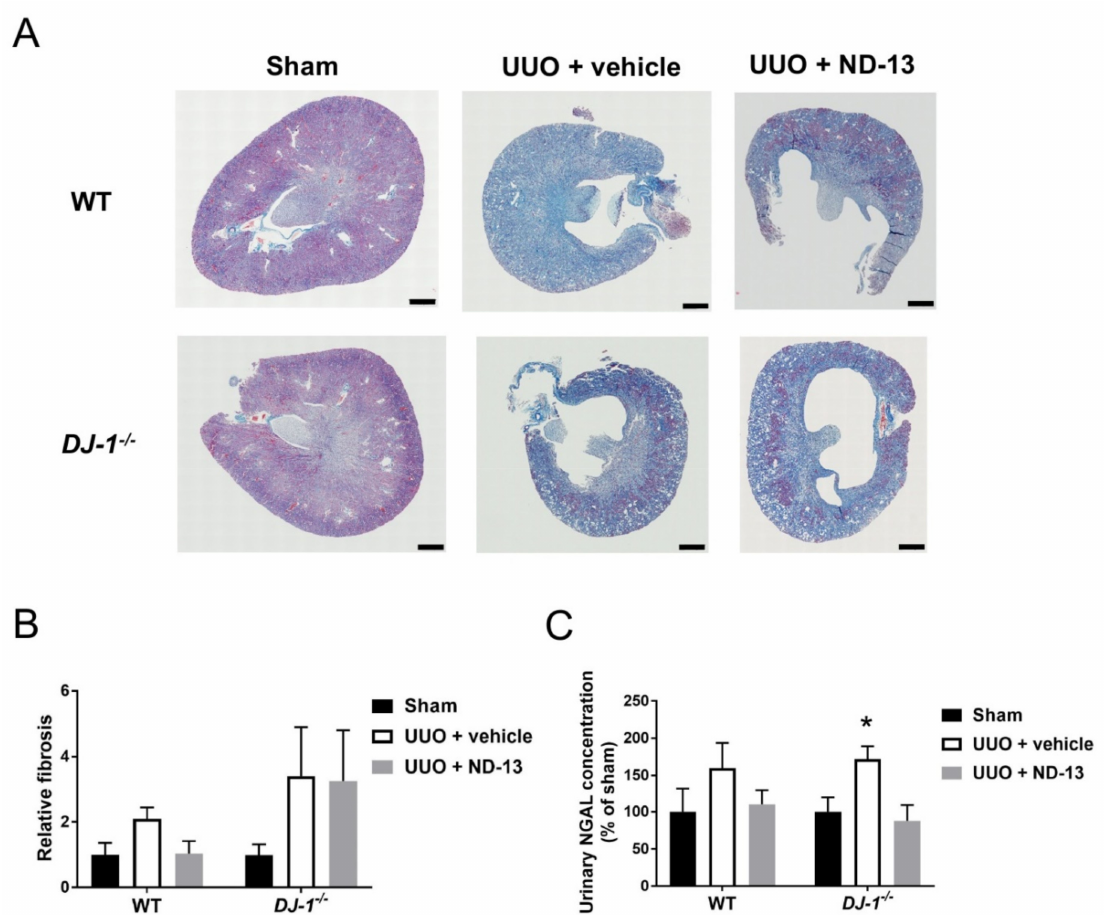
Figure 2. Treatment with ND-13 reduces UUO-induced renal fibrosis in WT mice. ( A ) Representative full scan images of Masson’s blue trichrome-stained kidneys obtained from WT and DJ-1 − / − mice that underwentshamsurgery, UUOandvehicletreatmentorUUOandND-13treatment(scale bar = 500 µ m). ( B ) Quantification of collagen deposition in renal cortex of WT and DJ-1 − / − mice that underwent sham surgery, UUO and vehicle treatment or UUO and ND-13 treatment. ( C ) Urinary concentration of the proximal tubule marker NGAL in WT and DJ-1 − / − mice that underwent sham surgery, UUO and vehicle treatment or UUO and ND-13 treatment. n = 4–5 / group; * p < 0.05 vs. same genotype sham, two-way ANOVA with Tukey’s post hoc